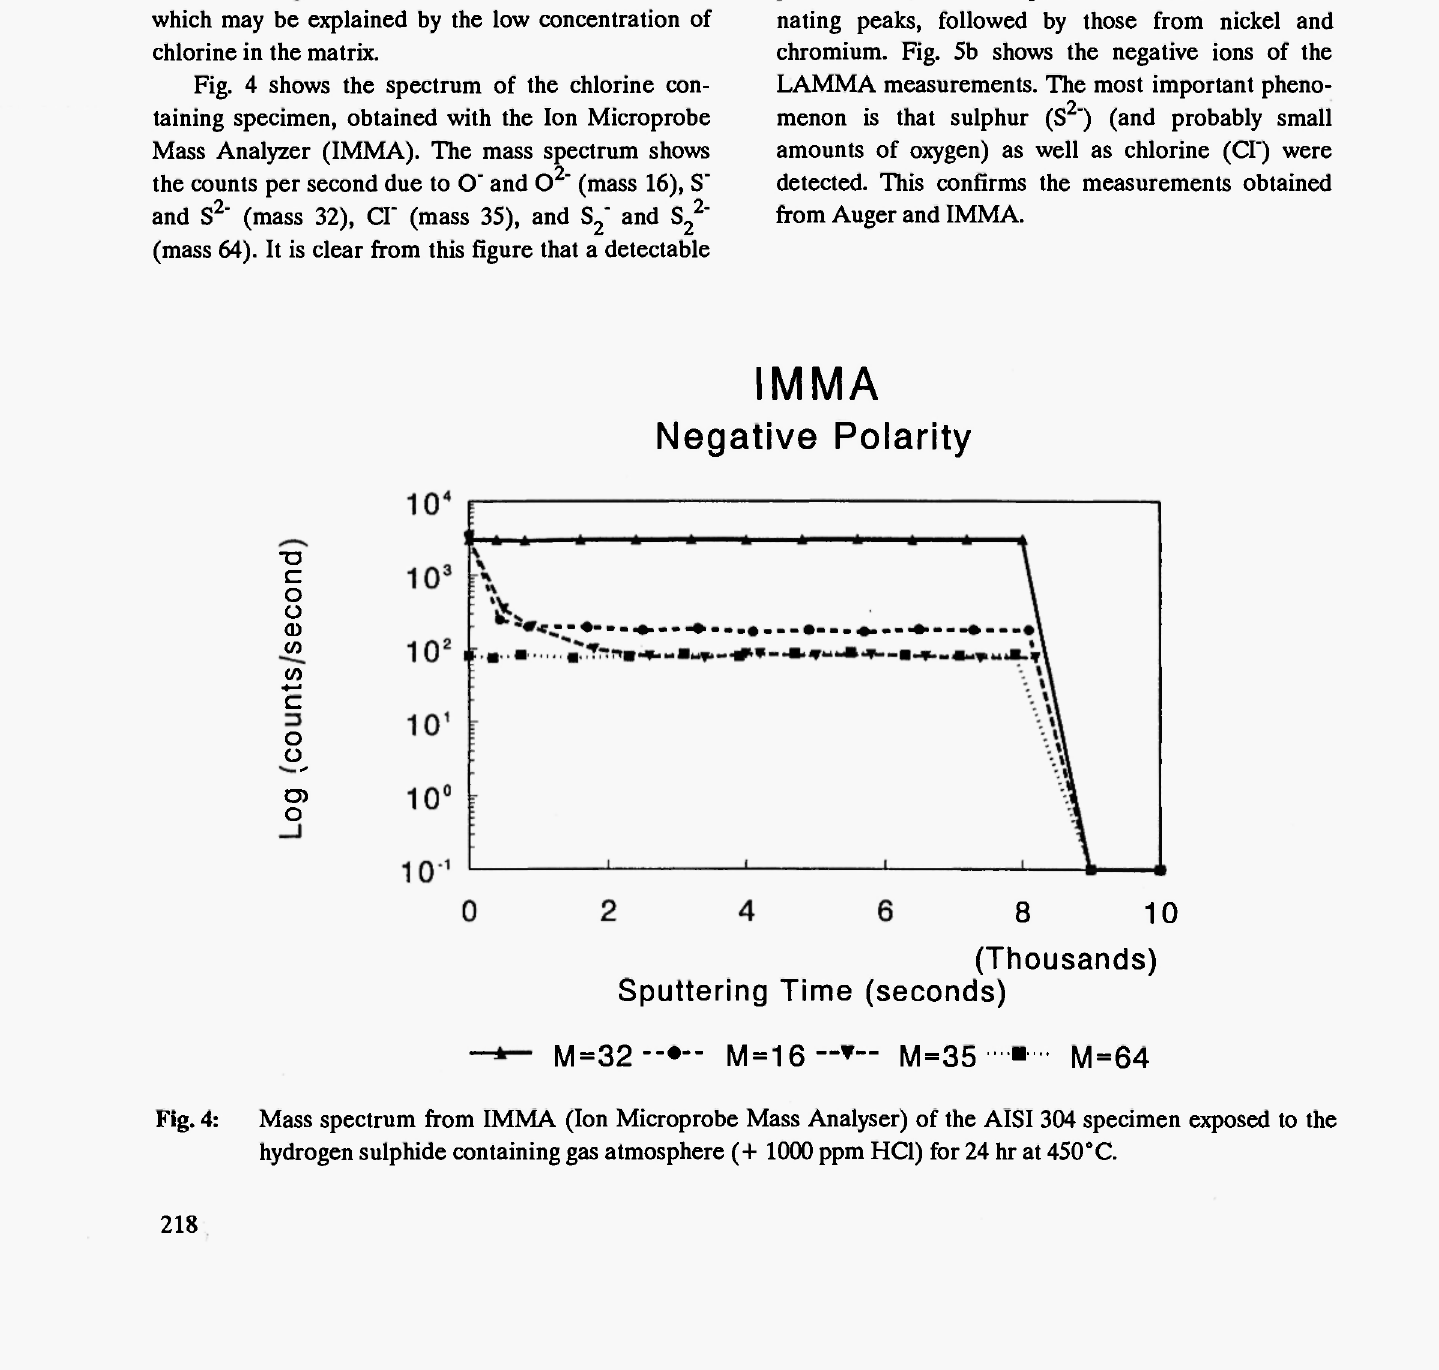
Fig. 4: Mass spectrum from IMMA (Ion Microprobe Mass Analyser) of the AISI 304 specimen exposed to the hydrogen sulphide containing gas atmosphere (+ 1000 ppm HCl) for 24 hr at